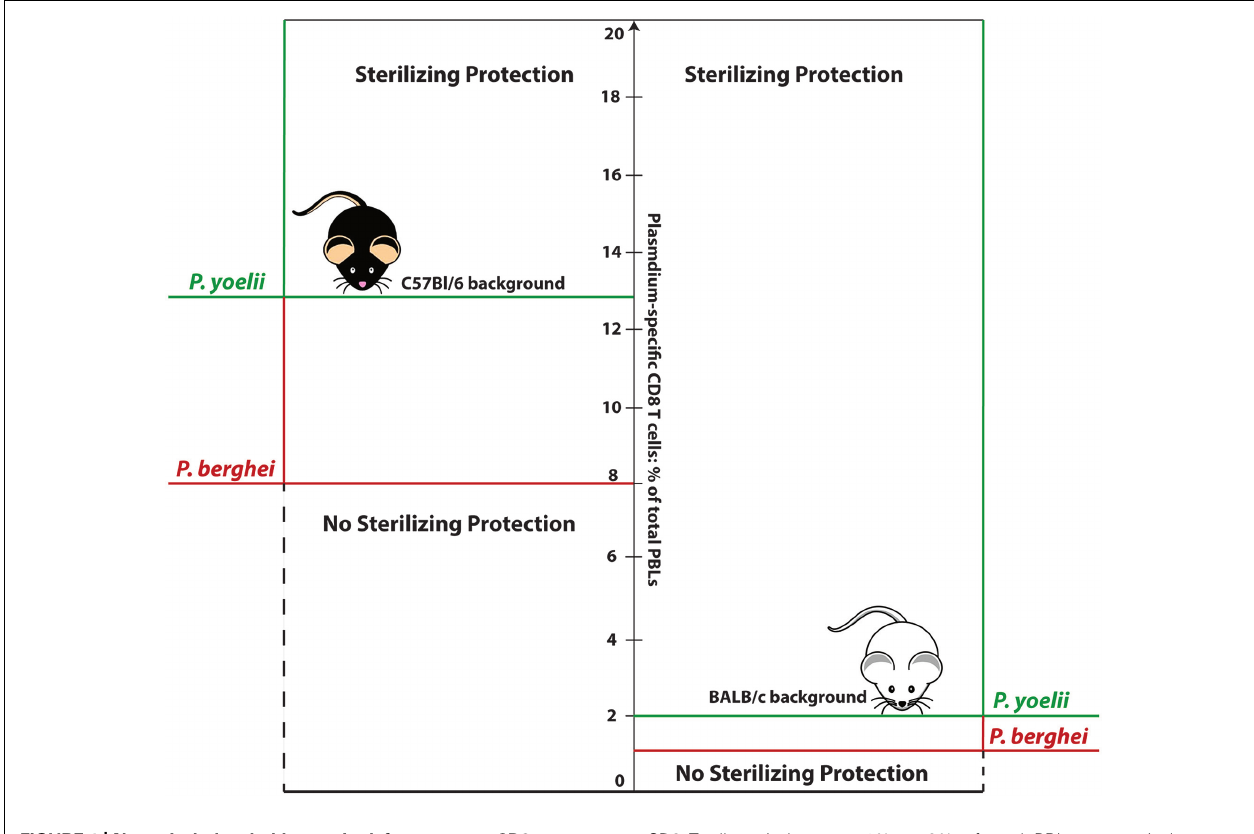
FIGURE 1 | Numerical thresholds required for memory CD8 T-cell-mediated sterilizing protection from sporozoite challenge: influence of host background genes and Plasmodium strain. Sterilizing protection of BALB/c mice against P. berghei or P. yoelii requires numbers of antigen- (CS-derived epitope) specific memory